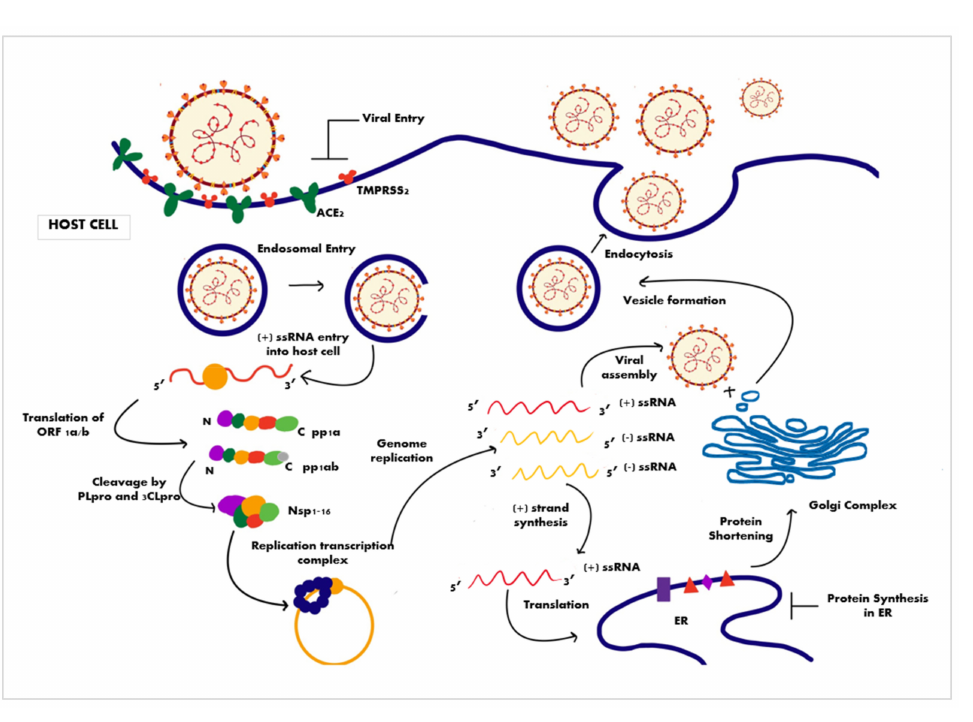
Figure 5. The SARS-CoV-2 viral life cycle with various stages as potential targets of therapeutic